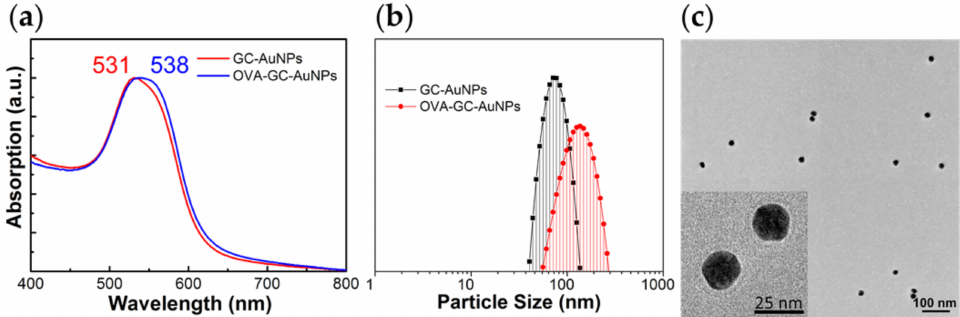
Figure 1. Characterization of GC-AuNPs: ( a ) The UV-vis spectrum presented surface plasmon resonance peak of GC-AuNPs at 531 nm and its red-shift to 538 nm after OVA conjugation to GC-AuNPs (OVA-GC-AuNPs); ( b ) Size distribution of GC- AuNP, measured with DLS, was 94.46 ± 46.45 nm. After OVA conjugation, the size increased to 127.03 ± 23.08 nm; ( c ) The TEM image illustrated the spherical morphology of OVA-GC-AuNPs. The TEM image of GC-AuNPs was indistinguishable from that of OVA-GC-AuNPs (not shown). The discrepancy between TEM images and DLS measurement was due to the hydrophilic property of glycol chitosan and OVA